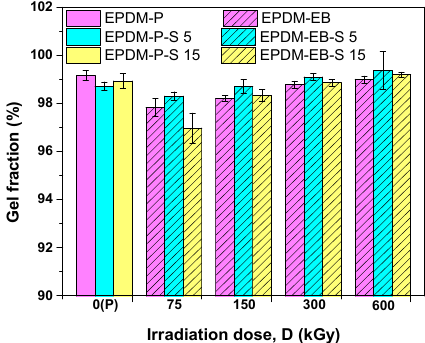
Figure 6. The effect of the cross-linking method (P/EB) and sawdust amount on the gel fraction. As the irradiation dose increased, the gel fraction also increased. The results obtained at the highest irradiation dose of 300 and 600 kGy are similar with those obtained in the case of peroxide cross-linking. In addition, samples containing 5 phr S cross-linked with EB (EPDM-EB-S 5) exhibit higher gel fractions than those without S (EPDM-EB) and with 15 phr S (EPDM-EB-S 15). Thus, in the